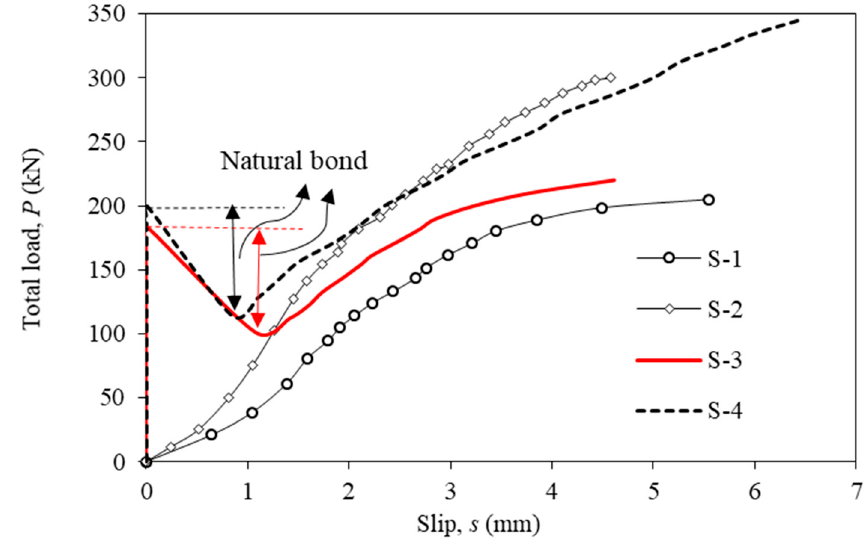
Figure 3. The load-slip curves for all of the specimens.